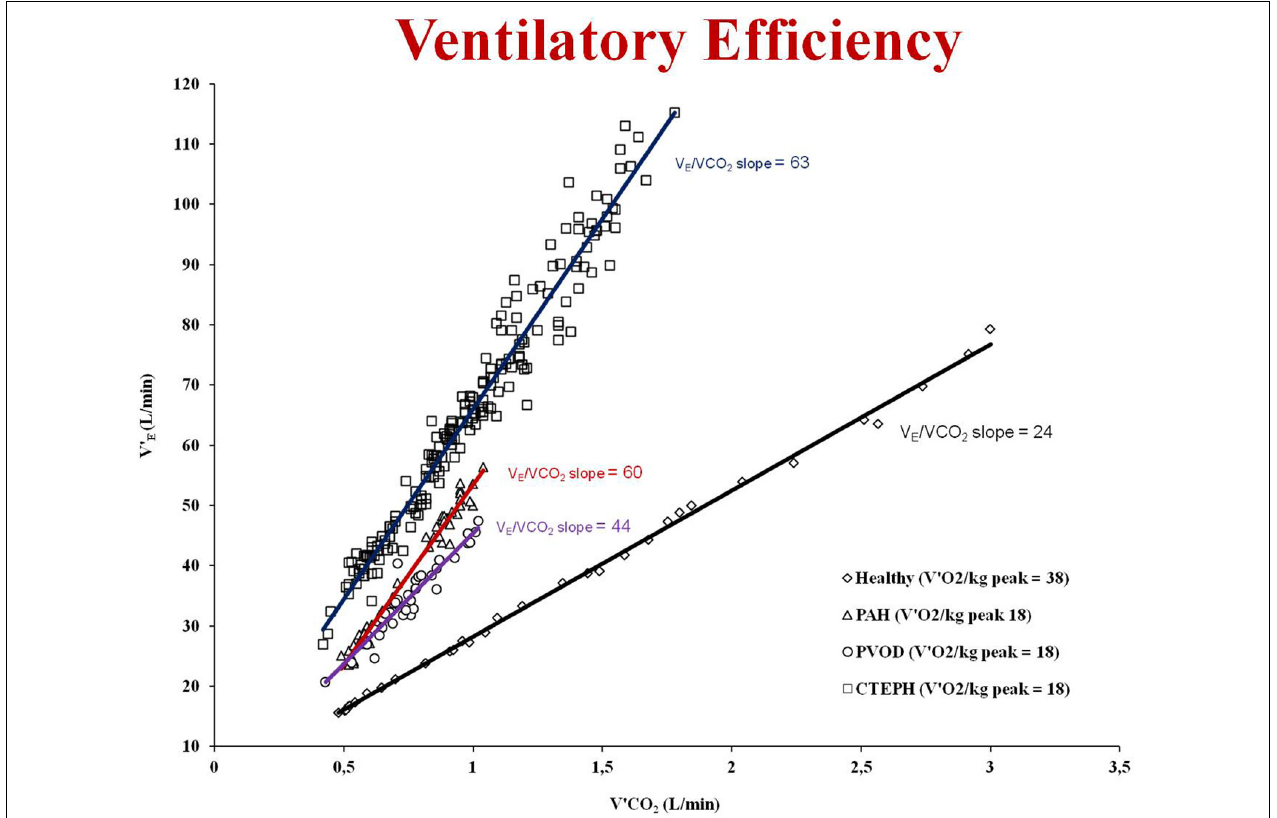
FIGURE 2 | Examples of ventilatory efficiency (V’ E /V’CO 2 slope) in a healthy subject with a peak oxygen uptake (V’O 2 ) of 38 mL/Kg/min (black line and rhomboid), in a patient with pulmonary veno-occlusive disease (PVOD) with a peak V’O 2 of 18 mL/Kg/min (violet line and circles), in a patient with pulmonary arterial hypertension (PAH) with a peak V’O 2 of 18 mL/Kg/min (red line and triangles) and in a patient with chronic thromboembolic pulmonary hypertension (CTEPH) with a peak V’O 2 of 18 mL/Kg/min (blue line and squares). This is an original figure, no permission is